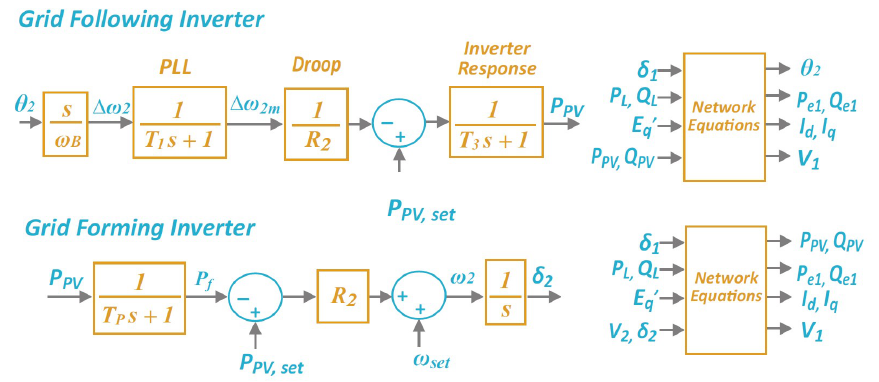
Figure 4. Grid-following and grid-forming inverter